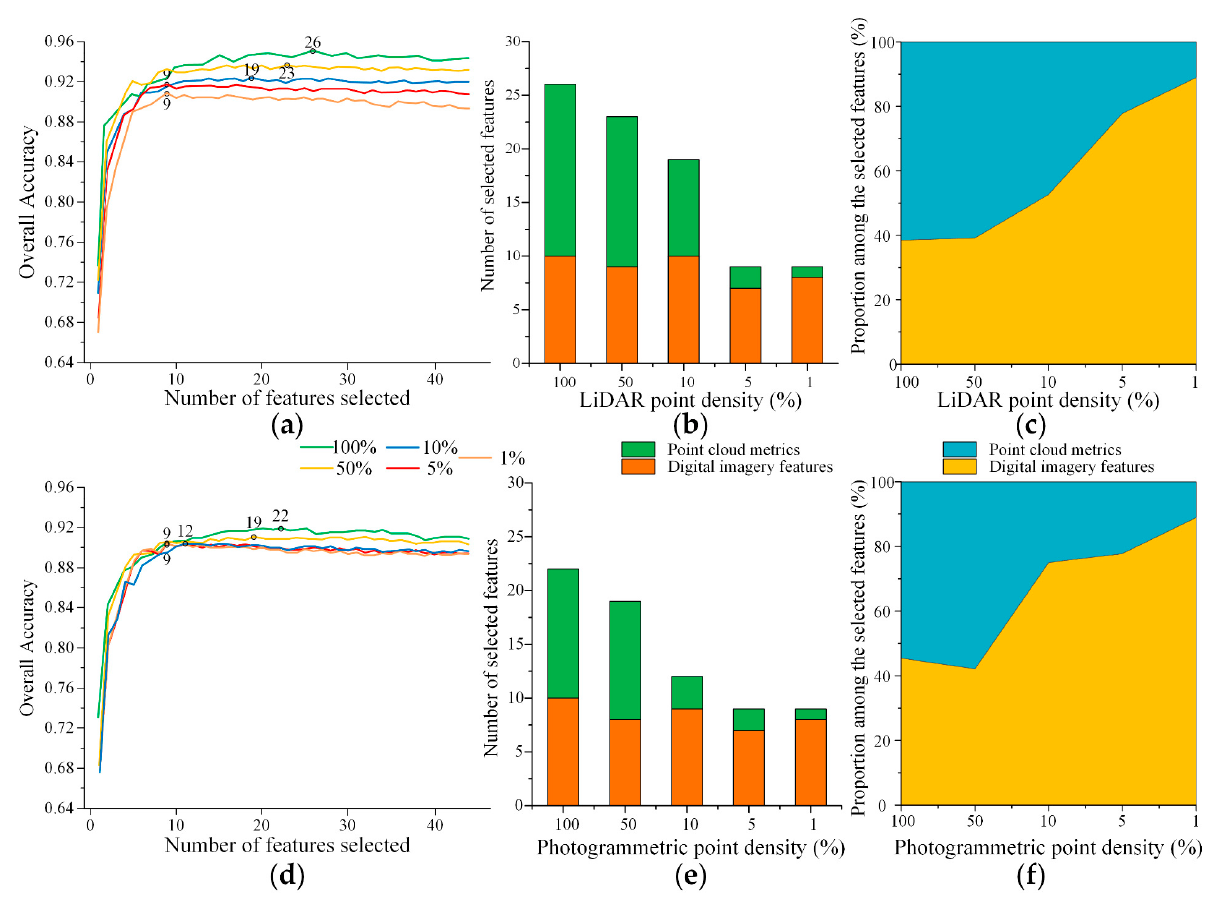
Figure 6. Variation in the overall accuracy with different numbers of features selected by the RF-based RFE algorithm and the details of the selected features for the LiDAR case ( a – c ) and photogrammetric case ( d – f ). Table 6. List of selected features for the LiDAR case with different LiDAR point densities.